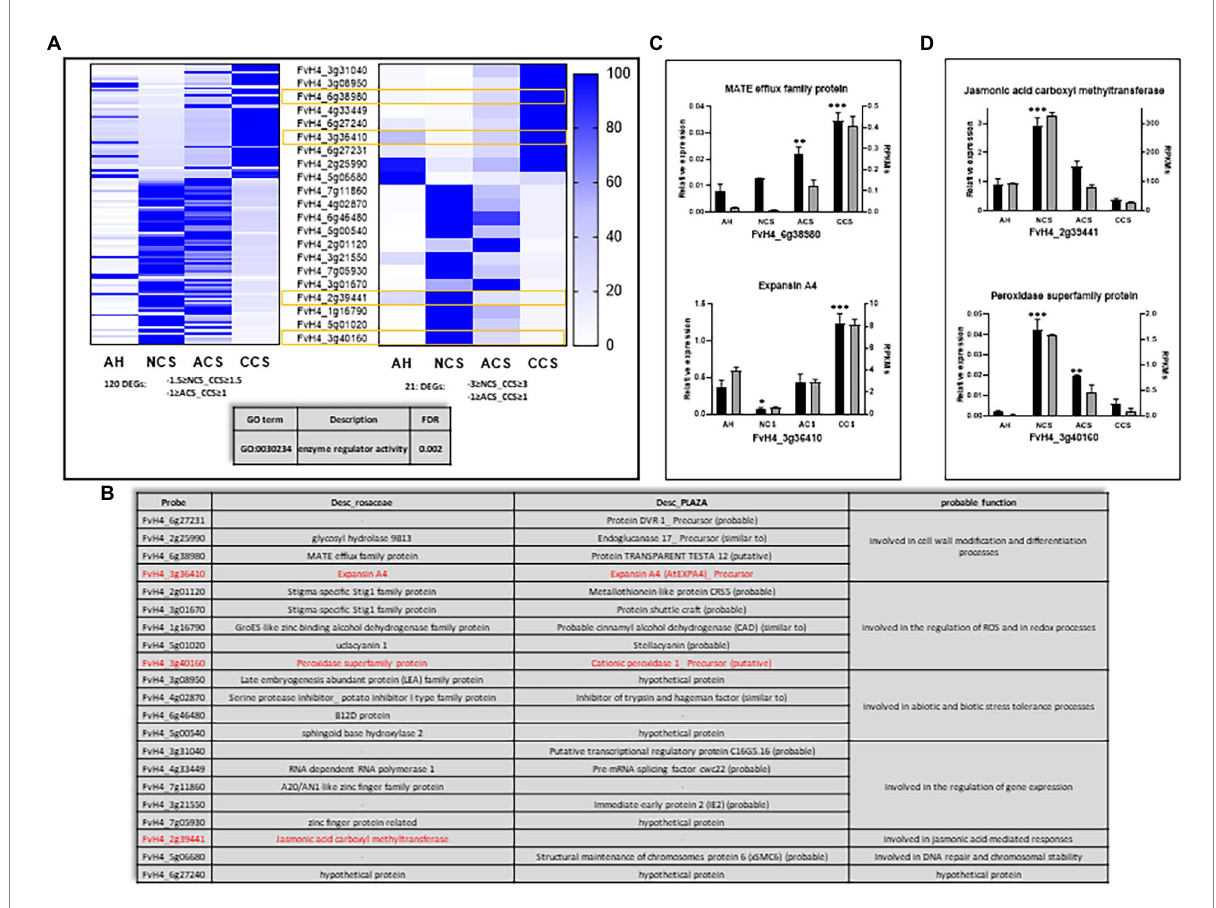
FIGURE 8 Genes differentially expressed at 20 ° C controlled by high CO 2 . (A) Heatmaps representing Reads Per Kilobase Million (RPKM) expressed as a relative percentage of the DEGs. Left: DEGs obtained from the intersection between-1.5 ≥ NCS_CCS ≥ 1.5 and-1 ≥ ACS_CCS ≥ 1; right: DEGs with highest change obtained from the intersection between-3 ≥ NCS_CCS ≥ 3 and-1 ≥ ACS_CCS ≥ 1, where a yellow square is indicating which genes are analyzed by qPCR. The table at bottom express the biological process term overrepresented obtaining by a Singular Enrichment Analysis (SEA; FDR ≤ 0.05). (B) Table showing a representative pool of DEGs regulated by high CO2 with its probable function. Relative expression analysis through qPCR (black bars) vs. RPKMs obtained in RNAseq (gray bars) for the genes: (C) FvH4_6g38980 and FvH4_3g36410, that are increasing its expression and (D) FvH4_2g39441 and FvH4_3g40160, that are repressing its expression by the CO2 treatment. Graphs represent the average of at least three independent replicates quantified. Error bars indicate ± SD; One-way ANOVA for relative expression of AH versus NCS, ACS, or